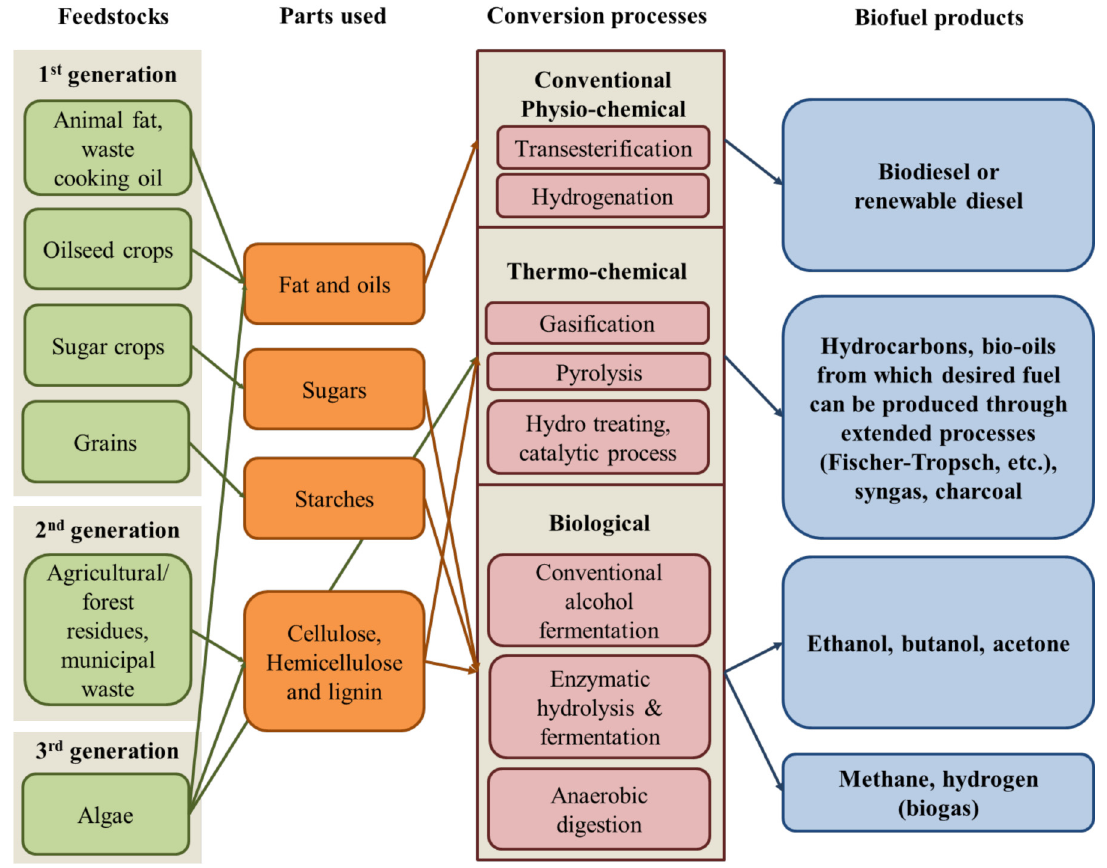
Fig. 1. Biofuel generation based on the feedstock, processes and